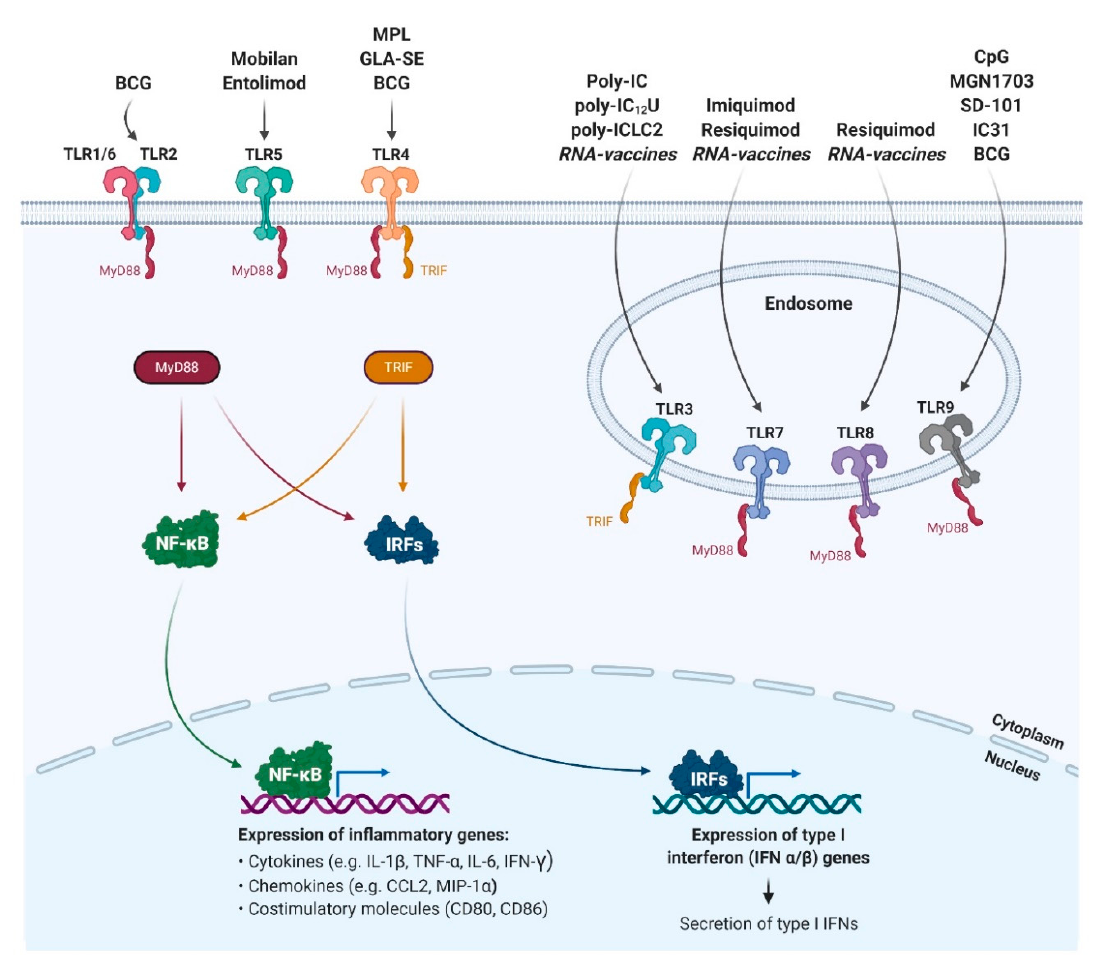
Figure 1. TLR-activating adjuvants and the induced signalling pathway. Cell surface TLRs (TLR1, TLR2, TLR4, TLR5, TLR6) and intracellular (endosomal) TLRs (TLR3, TLR7, TLR8, TLR9) are the targets of the illustrated adjuvants. Upon binding of the appropriate adjuvant by the LRR domain, TLRs recruit TIR domain-containing adaptor proteins like MyD88 and TRIF, which activate NF- κ B signalling, MAP kinases (not shown) and IRFs) (e.g., IRF3, IRF7 mediated type I IFN responses). This initiates the expression of pro-inflammatory cytokines such as TNF- α , IL-6, IFN- γ or the type I interferons IFN- α and IFN- β . The TIR domain-containing adapter proteins in the figure are colour-coded to show whether the signalling of each TLR is MyD88- or TRIF-dependent. Abbreviations: TLR (Toll-like receptor), LRR (leucine-rich repeat), TIR (Toll-Interleukin receptor), MyD88 (myeloid differentiation factor 88), TRIF (TIR domain-containing adaptor protein inducing IFN β ), NF- κ B (nuclear factor kappa-light-chain-enhancer of activated B cells), MAP (mitogen-activated protein), IRF (Interferon Regulatory Factor), IFN (Interferon), TNF- α (tumour necrosis factor-alpha), IL (Interleukin); Created with BioRender.com.